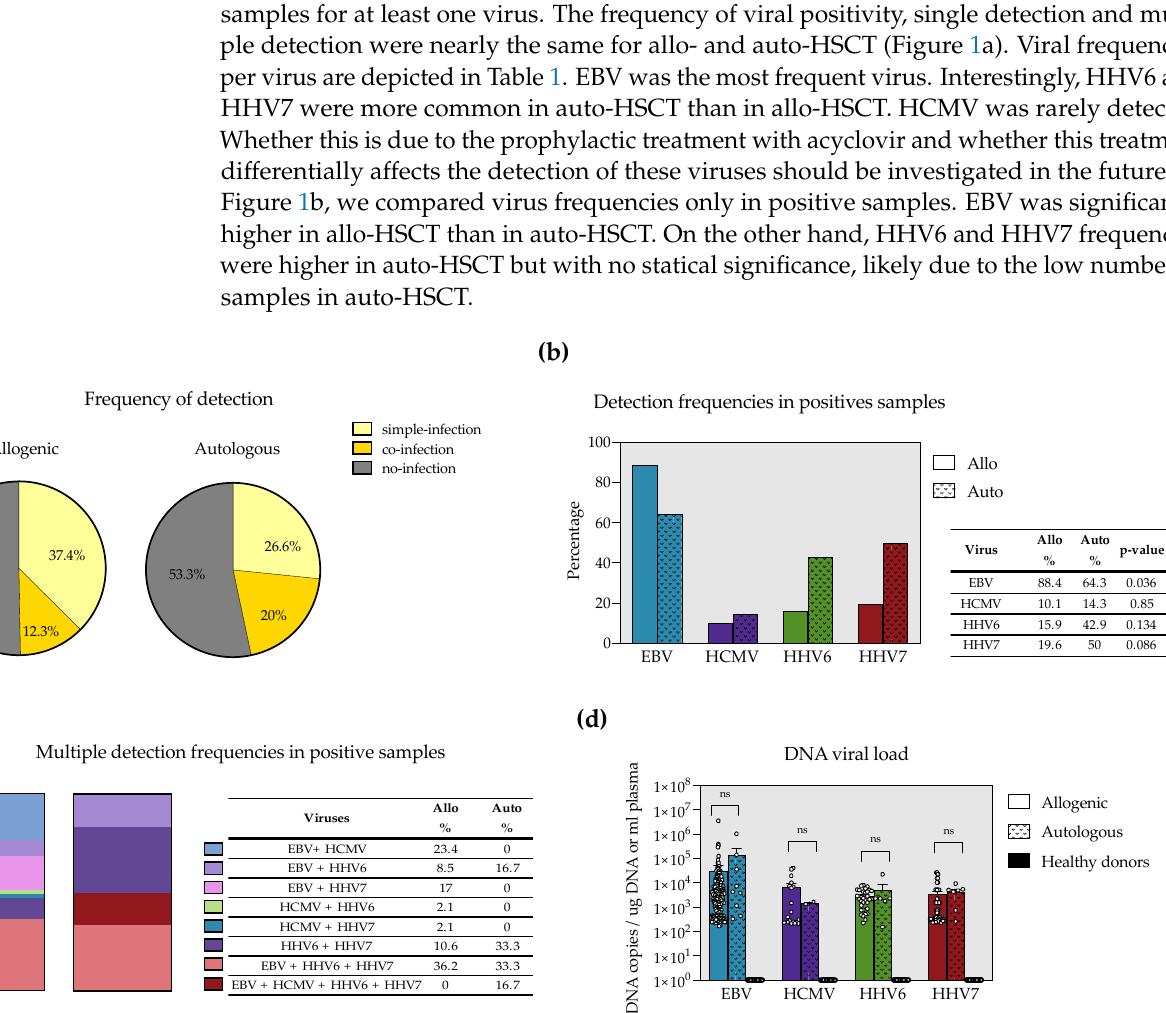
Figure 1. Frequency of single and multiple detection of EBV, HCMV, HHV6 and HHV7 in childhood allogeneic (allo) and autologous (auto) hematopoietic stem cell transplant (HSCT). Comparison of detection status ( a ), overall detection ( b ) and multiple detection ( c ) episodes between allo- and auto-HSCT. In ( b ), frequencies were compared by the Test of Difference in proportions. ( d ) Magnitude of the viral load seen for each virus in allo-, auto-HSCT and healthy donors. Mann–Whitney’s test was used to compare allo- versus auto-HSCT.